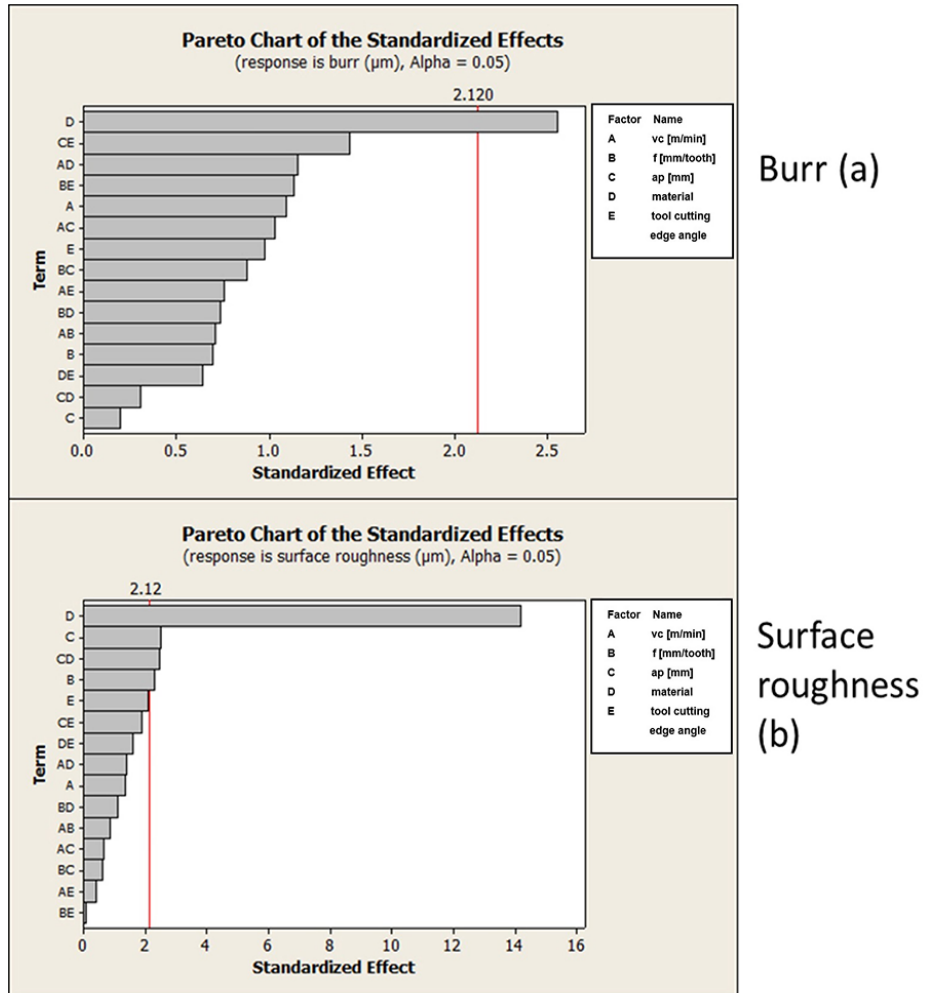
Figure 2. Pareto charts of burrs size sand surface roughness for both materials